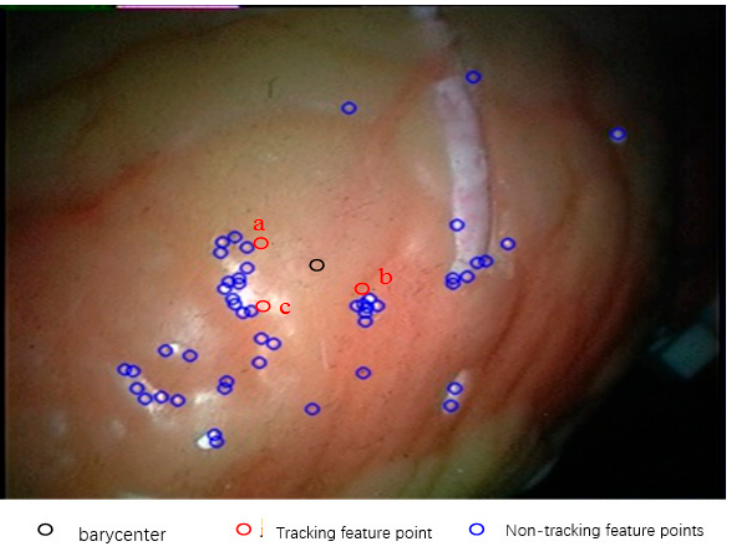
Figure 14. Selection of tracking points.